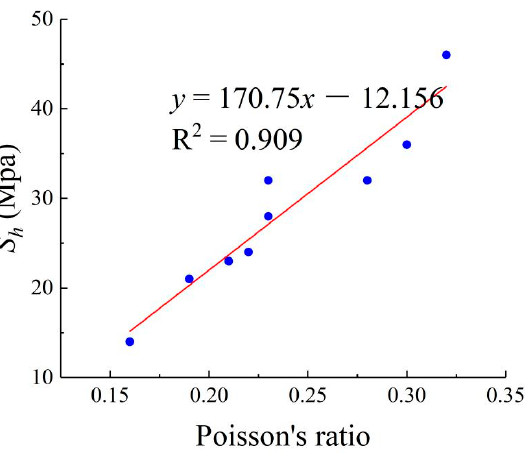
Figure 18. The relationship between minimum horizontal stress and Poisson’s ratio.